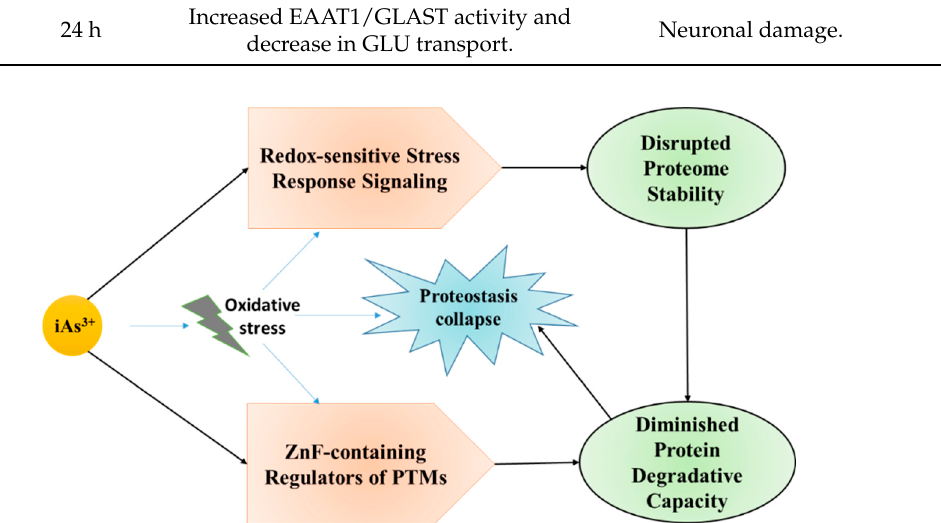
Figure 2. Pathway of inorganic arsenic-induced oxidative stress leading to proteostasis collapse by disrupting the functions of Zinc finger proteins (ZnF) and redox sensitive stress response signaling, which further leads to disrupted proteome stability and diminished protein degradative capacity.